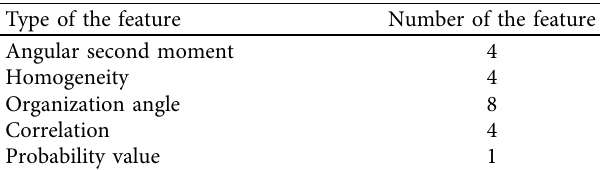
Figure 5: Neighborhood properties including edge information. Table 1: Types of features and